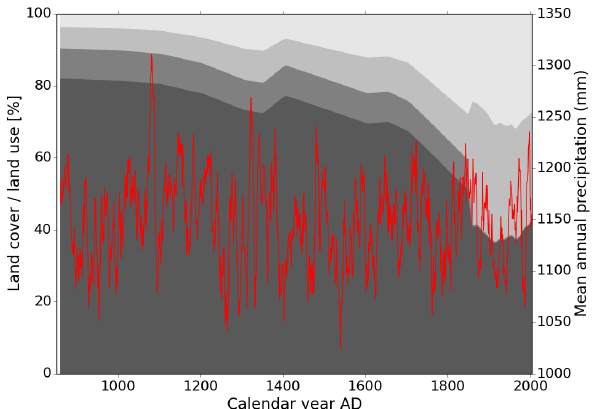
Figure 5. Land cover and precipitation variability averaged over the Rhine catchment for the last millennium. The red line is the 10-year mean total precipitation for the Rhine catchment. The background colors are land cover types, starting from the darkest grey to the lightest: forest, bare soil, grass, crop and pasture. Land cover and precipitation data are from MPI-ESM.